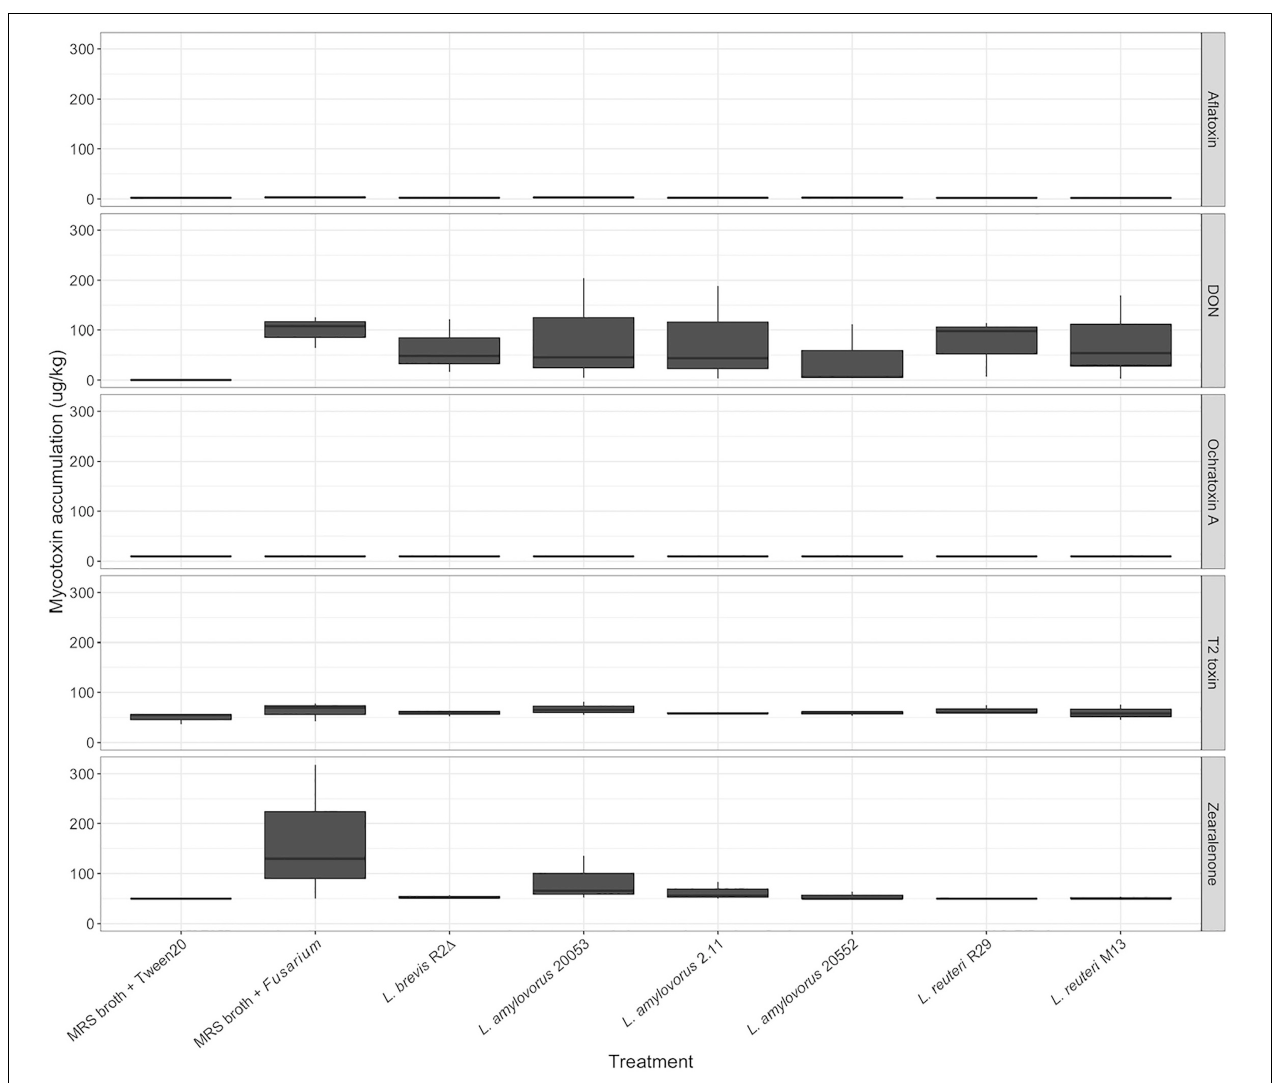
FIGURE 4 | Mycotoxin accumulation in pooled FHB grain samples. Mycotoxin means were separated using the Kruskal–Wallis H